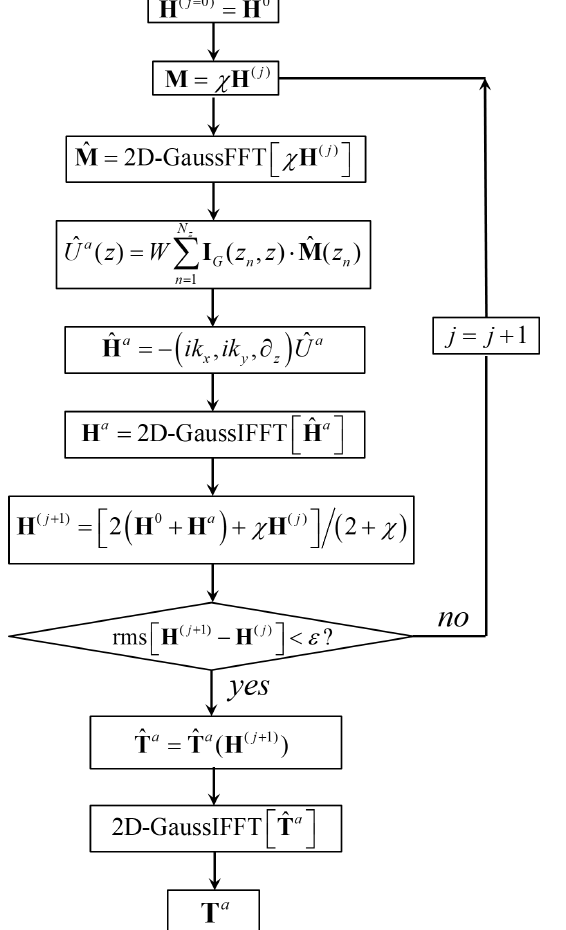
Figure 2. Workflow for modeling the magnetic gradient tensor produced by 3D magnetic bodies with high susceptibility (modified after